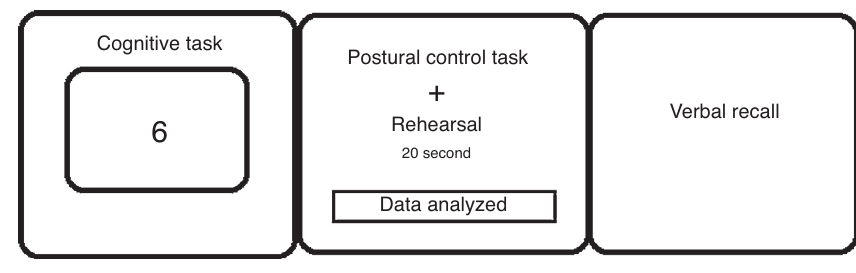
Figure 2 Illustration of the dual task